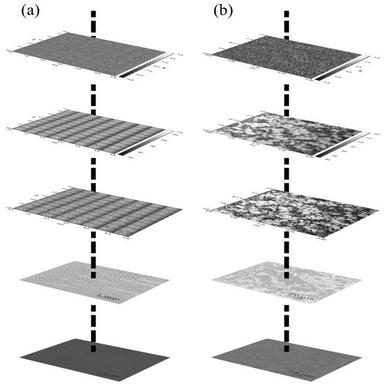
Multi-parameter mapping information of microstructural characteristics corresponding to the regions of different scales in materials: (a) the macroscopic region corresponding to the etching region in TC4 titanium alloy; (b) the microscopic region corresponding to a micro-region in the etching region.